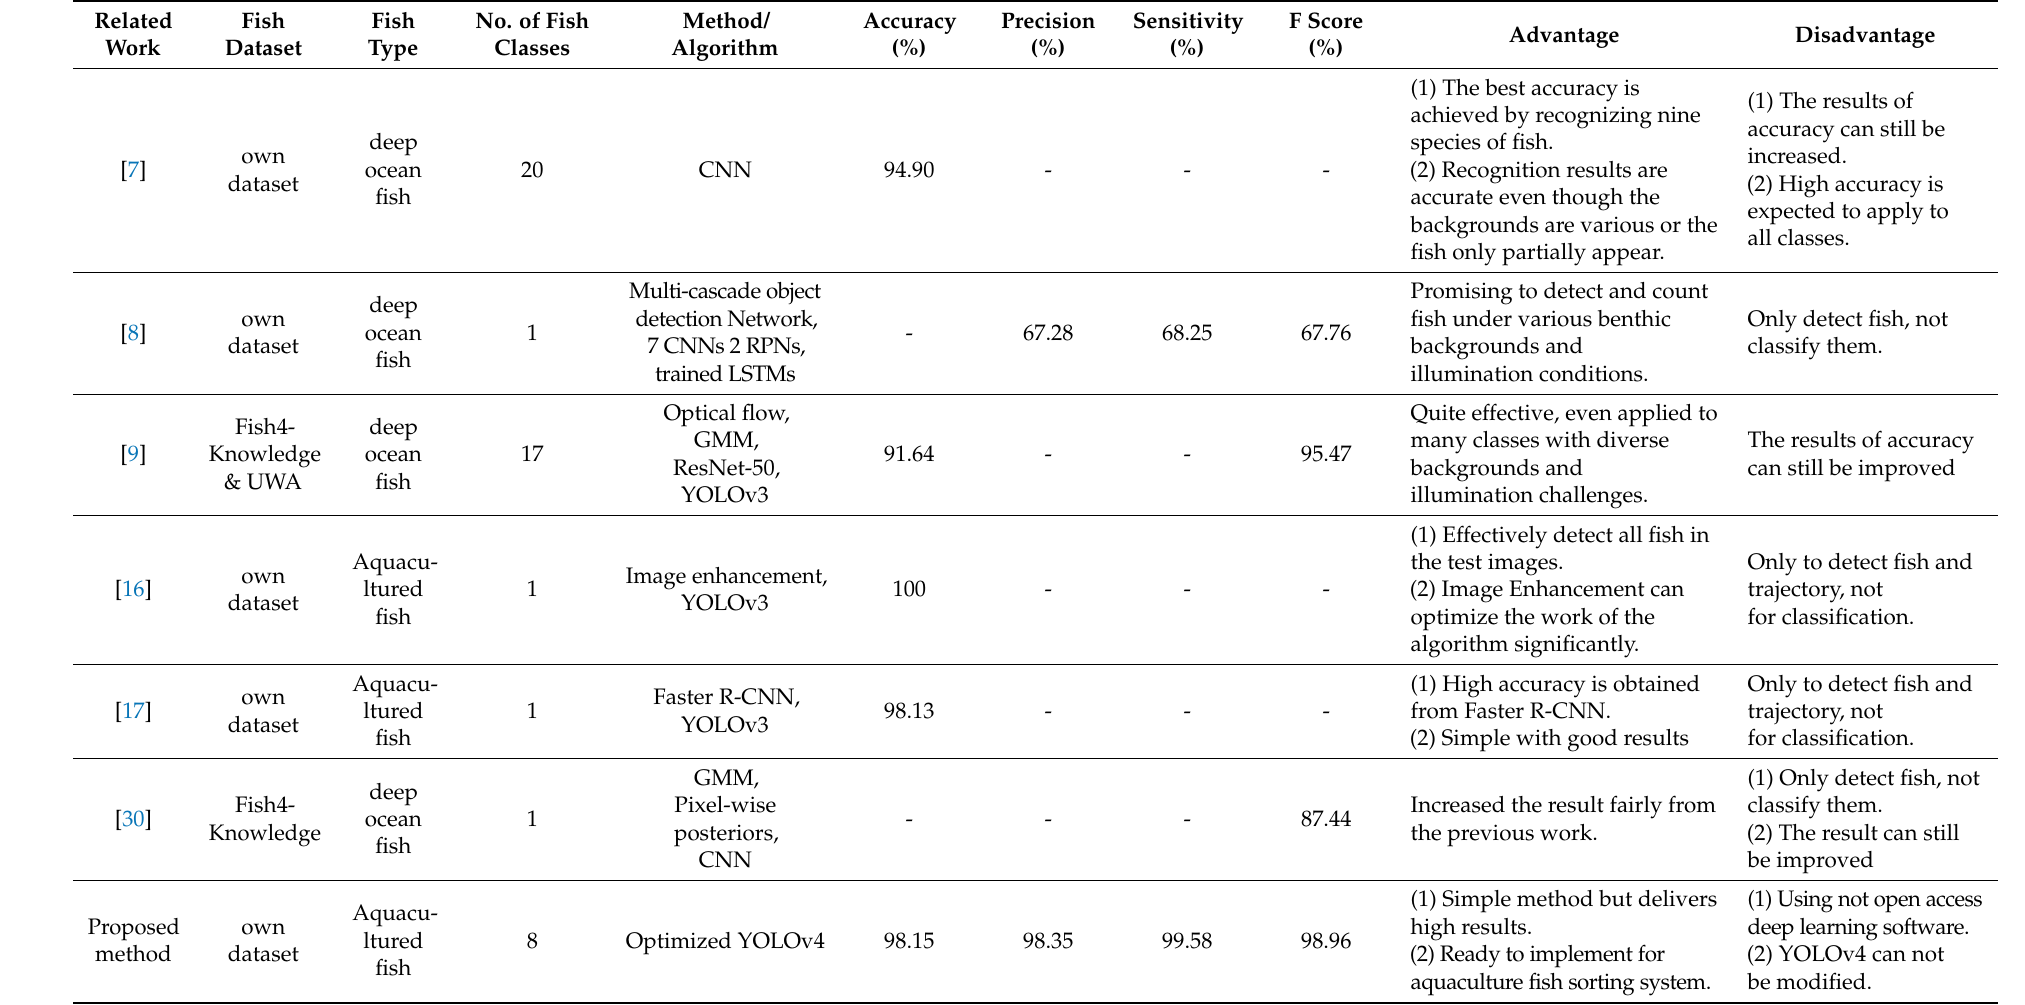
Table 7. Comparison chart of previously related works with the proposed